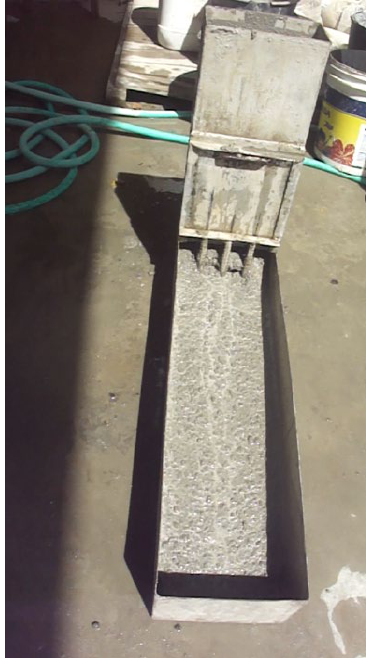
Figure 2. L-Box test in laboratory.